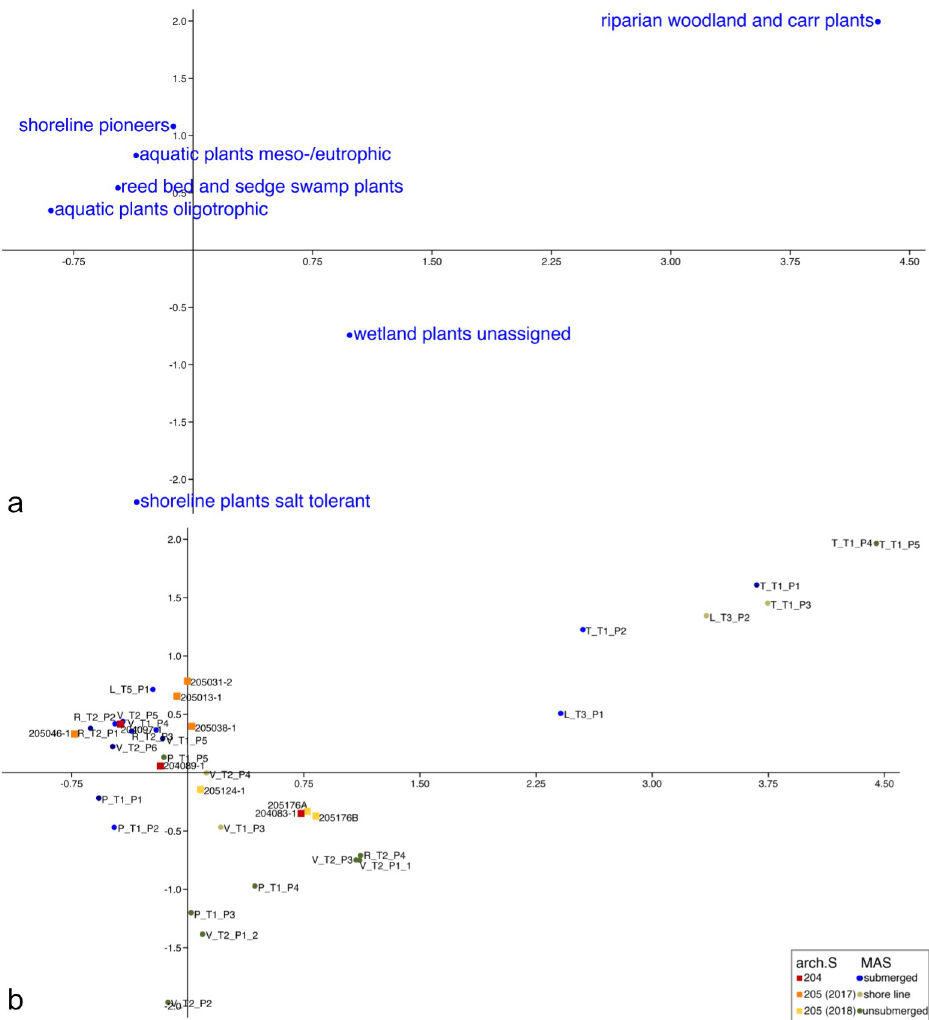
Fig 10. CA-graph based on density values of ecological groupings of aquatic and wetland plants in modern analogue and archaeological samples. (a) Columns, (b) rows. Percentage of variation explained by the first two dimensions of CA: